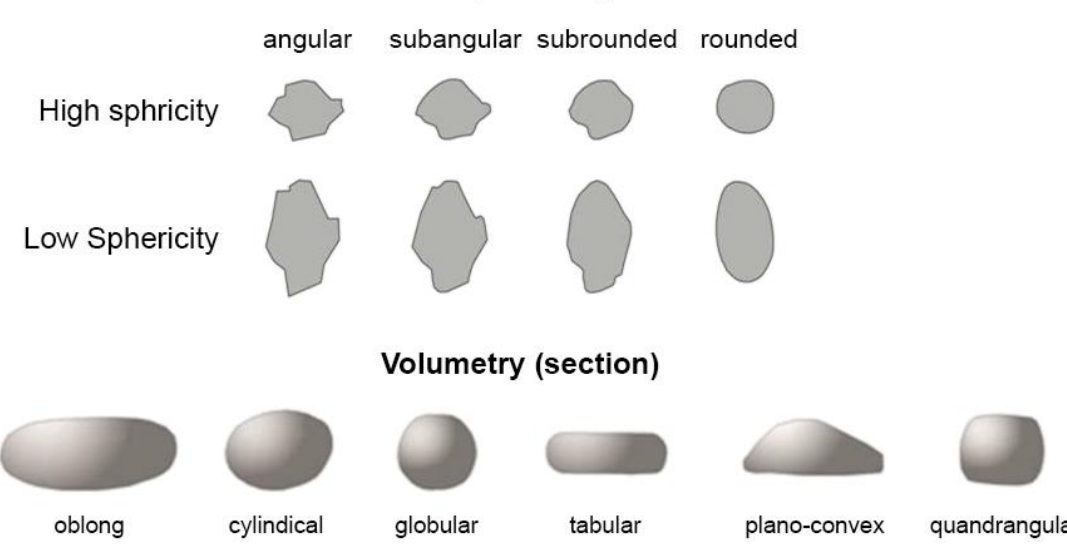
Figure 9. Morphometry and volumetry in section pebbles parameters of